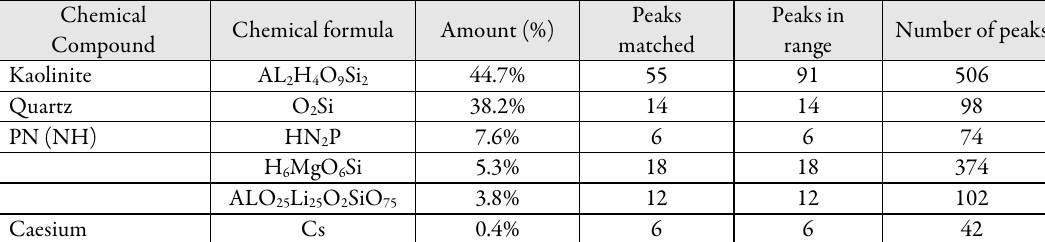
Table 1. Chemical composition of calabash chalk